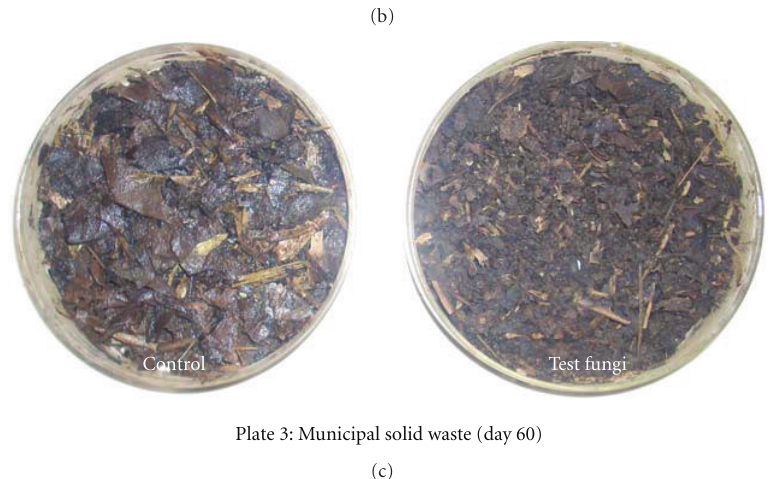
Figure 4: Bioconversion of municipal solid waste by using spore suspension of T. viride in petri plates.